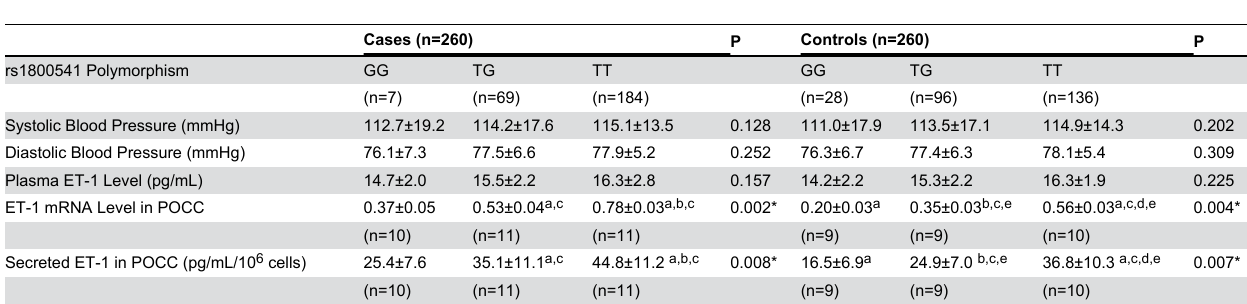
Table 4. Blood Pressure and Endothelin-1 (ET-1) Levels in Study Subjects by the rs1800541